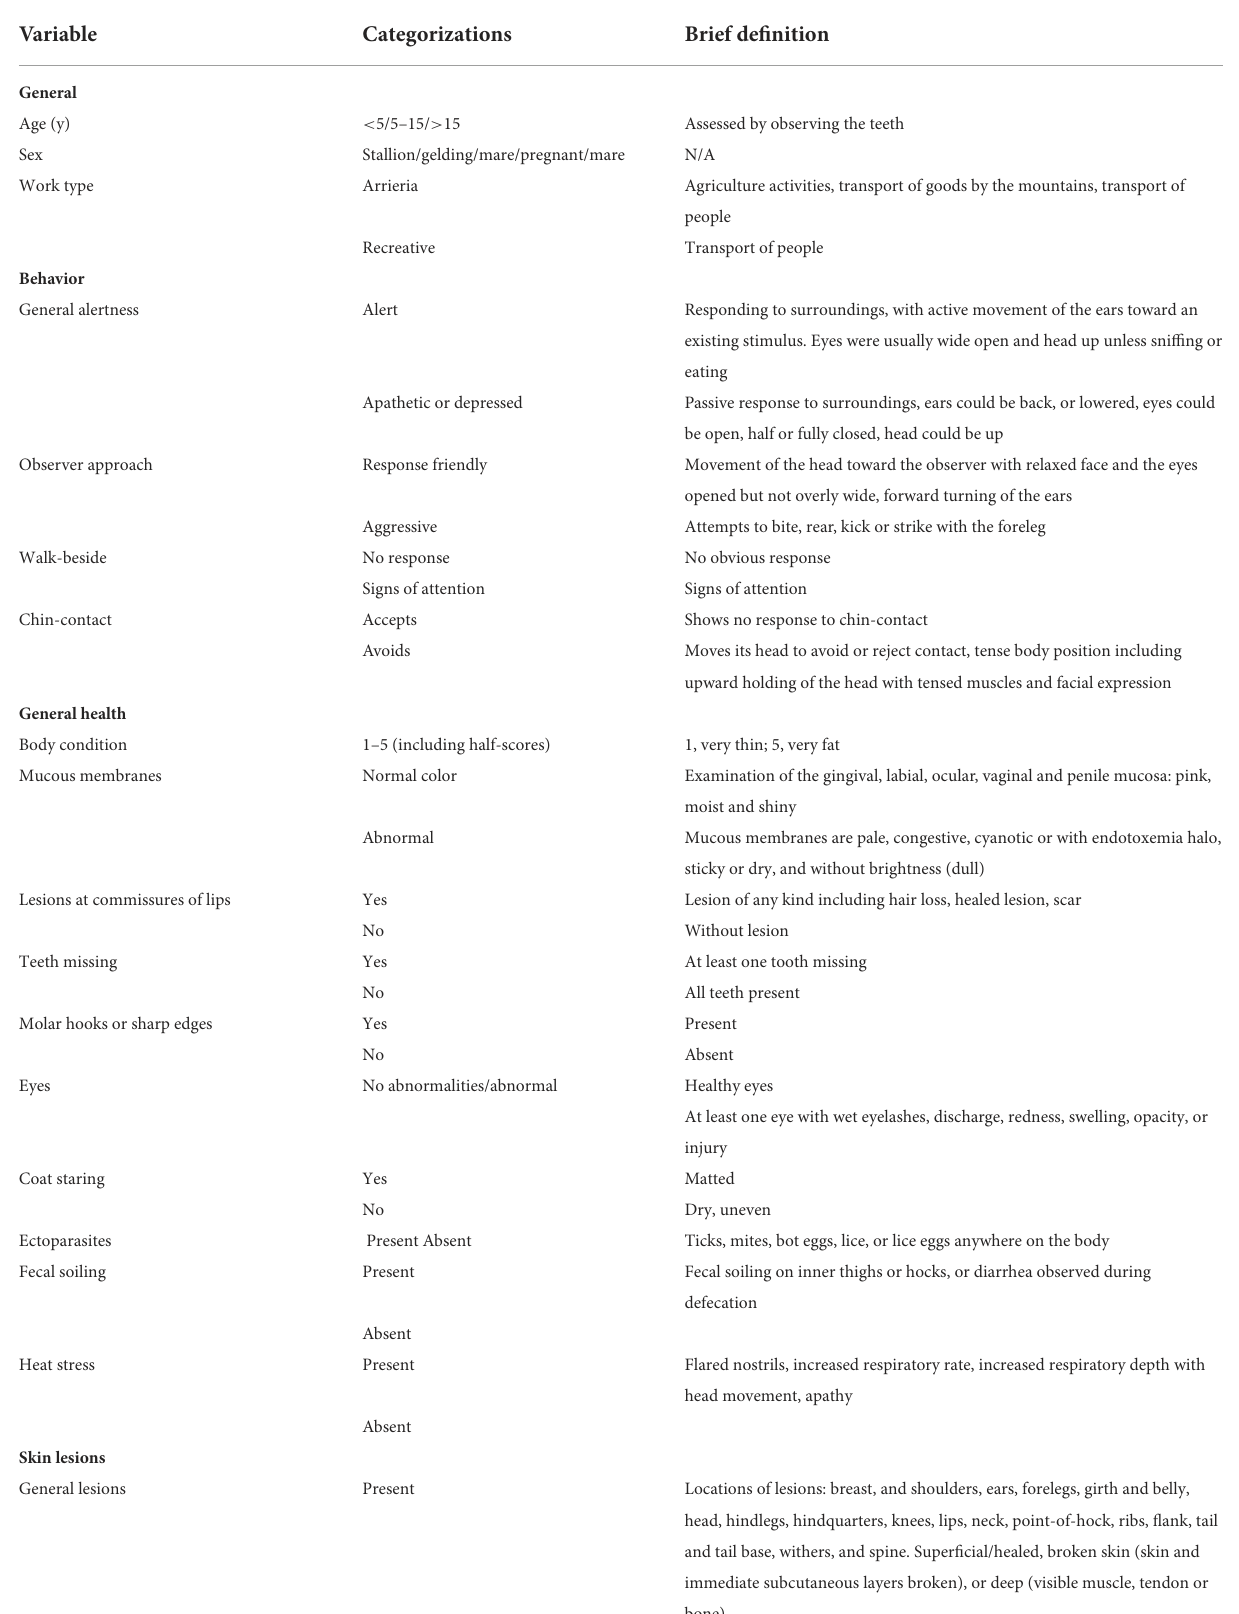
TABLE 1 Brief descriptions of the behavioral and physical measures taken as part of a working equine welfare assessment (4, 10).